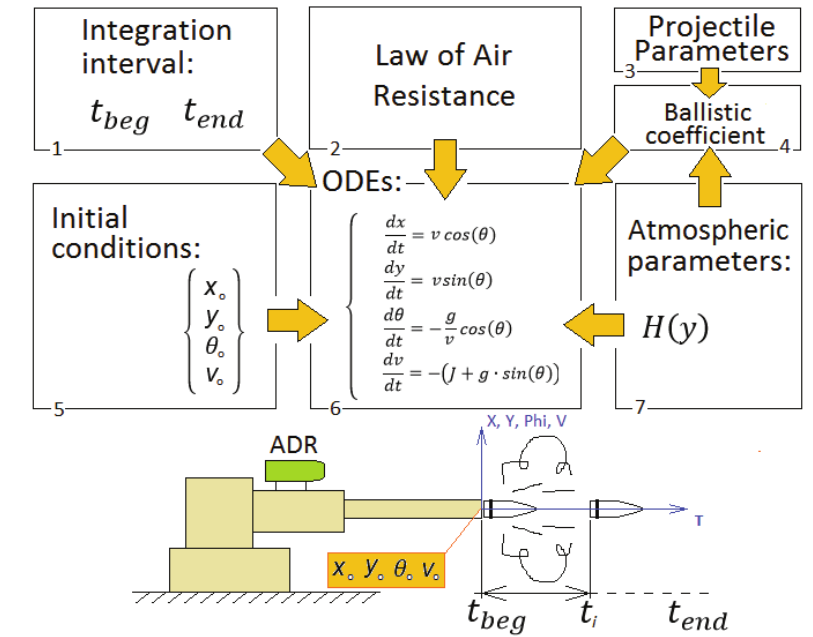
Figure 1 – The main task of external ballistics as the Cauchy problem Рис . 1 – Основная задача внешней баллистики в виде задачи Коши Слика 1 – Основни задатак спољње балистике у облику Кошијевог